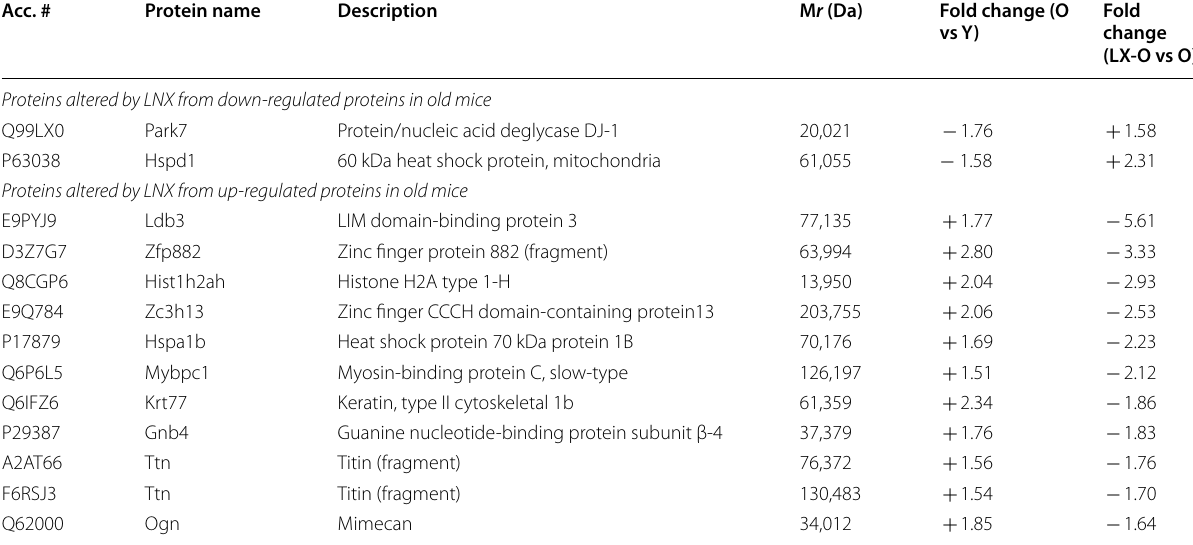
Table 2 List of recovered muscle proteins in LNX‑fed old mice from up‑ or down‑regulated proteins of old versus young mice Acc.